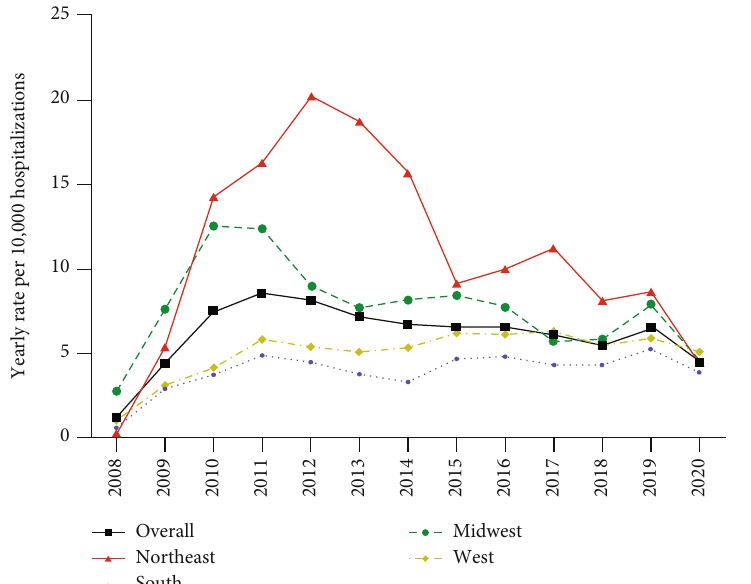
Figure 1: Annual rate of admission for infantile hemangiomas per 10,000 hospitalizations by geographic region. Trend of annual rate of inpatient admission per 10,000 hospitalizations for the treatment of infantile hemangiomas by geographic region from 2008 to